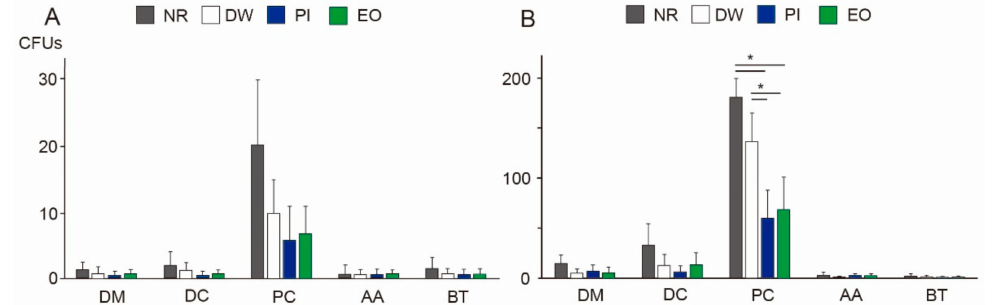
Figure 3. Viable counts on agar plates at various locations, following 10 min of scaling. Results show colony forming units (CFUs) at eHVE distances of ( A ) 10 cm and ( B ) 20 cm relative to the mouth. Results are shown as means ± standard deviation (SD). * p < 0.05. DM: doctor’s mask; DC: doctor’s chest area; PC: patient’s chest area; AA: assistant area; BT: bracket table; NR: no rinsing; DW: distilled water; PI: povidone-iodine; EO: essential oil.